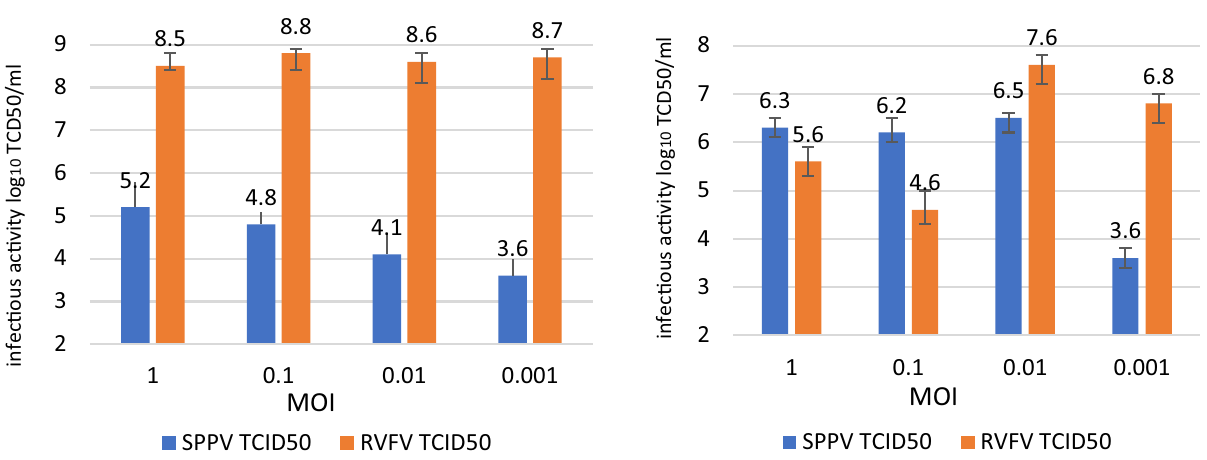
Figure 2. Infectivity titers of SPPV and RVFV co-cultured in Vero cells ( A ) and in LT cells ( B ) at different MOI 1, 0.1, 0.01 and 0.001. Data shown are means of at least 3 independent